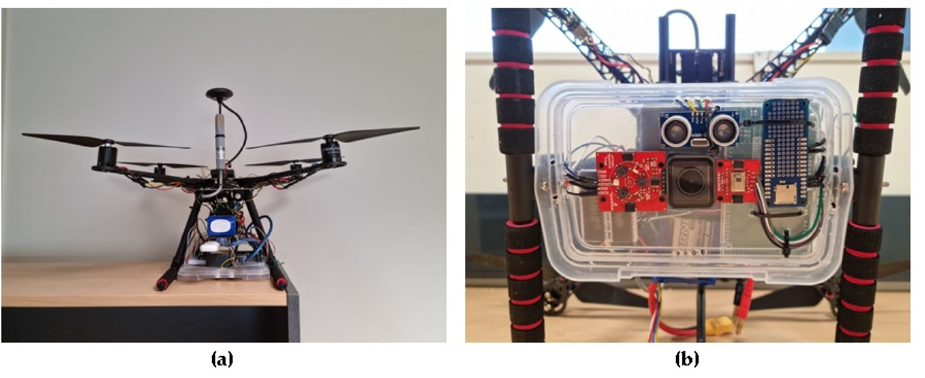
Figure 3. Aerial node components: ( a ) quadcopter UAV, ( b ) sensing component including RGB, infrared, spectrometer, and ultrasonic proximity sensors.